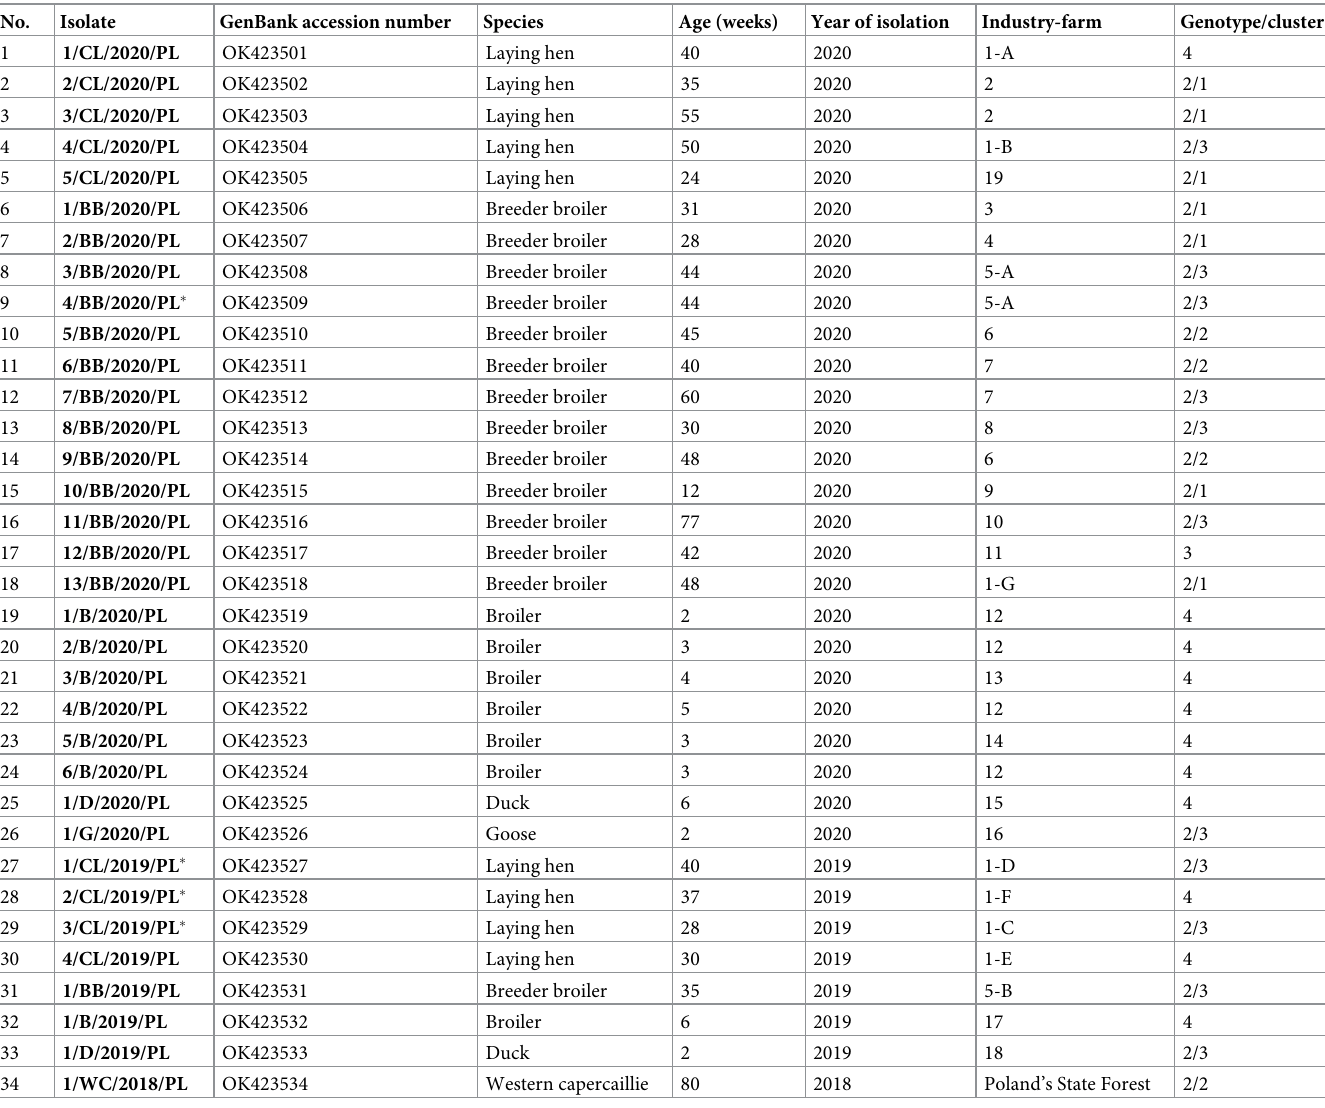
Table 1. Description of positive sequences obtained in this